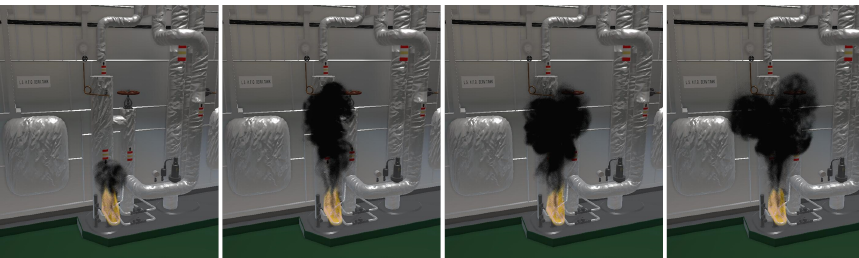
Figure 10. The engine fire at initial stage.